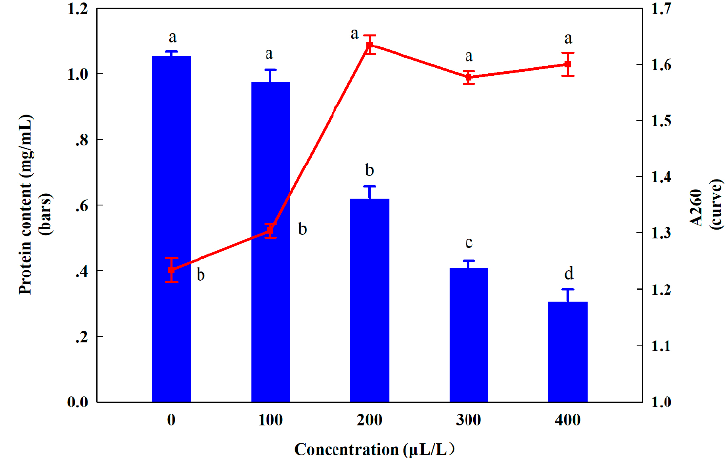
Figure 7. E ff ect of clove oil on nucleic acid leakage and protein content of C. gloeosporioides . Note: Di ff erent lowercase letters indicate a significant di ff erence at the 5%